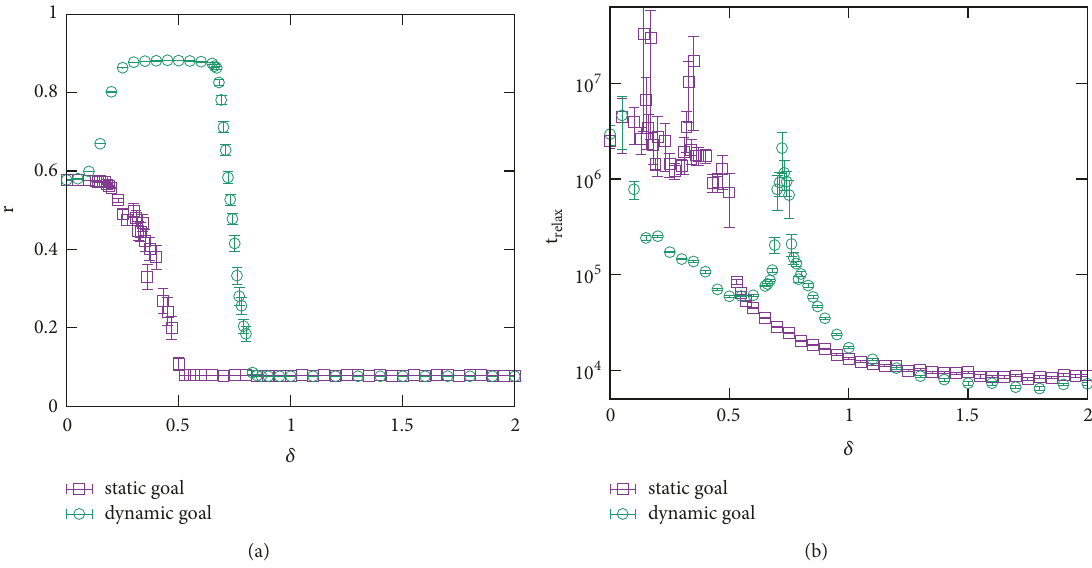
Figure 4: Comparison between agents which attempt to maximize the influence of their (dynamic) opinions with agents which optimize the influencewith regard to static randomly drawn goals (static). Dependenceof (a) the averaged opinion spread and (b) averagerelaxation times on the tolerance parameter 훿 . Results are averaged over 50 independent runs for a system of 푁 = 1000 nodes, noise Δ = 0.001 , ⟨푘⟩ = 10 , and 푚 = 3